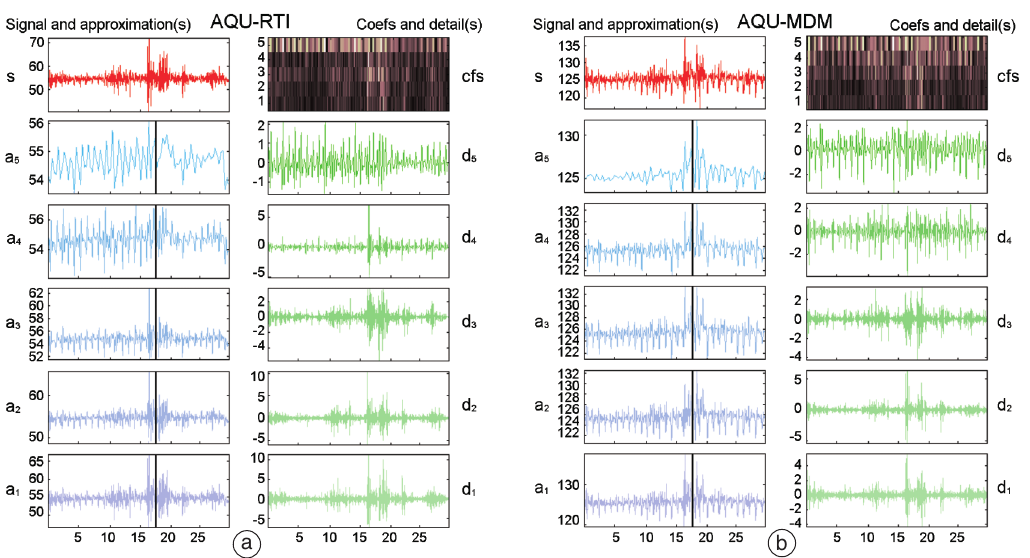
a Fig. 5a,b. A 5-level decomposition of the differences a) AQU-RTI and b) AQU-MDM for the month of April 2002 by means of «db3» wavelet. On April 18th 2002 an earthquake occurred outside the area covered by the network (marked as vertical line in left panels). Signal and approximations from step1 to 5, and coefficients and details from step1 to 5 are shown in the left and right hand side, respectively (see text). In each approximation and detailed panels, the horizontal axis indicates time in days while in the vertical axis unit is nT.